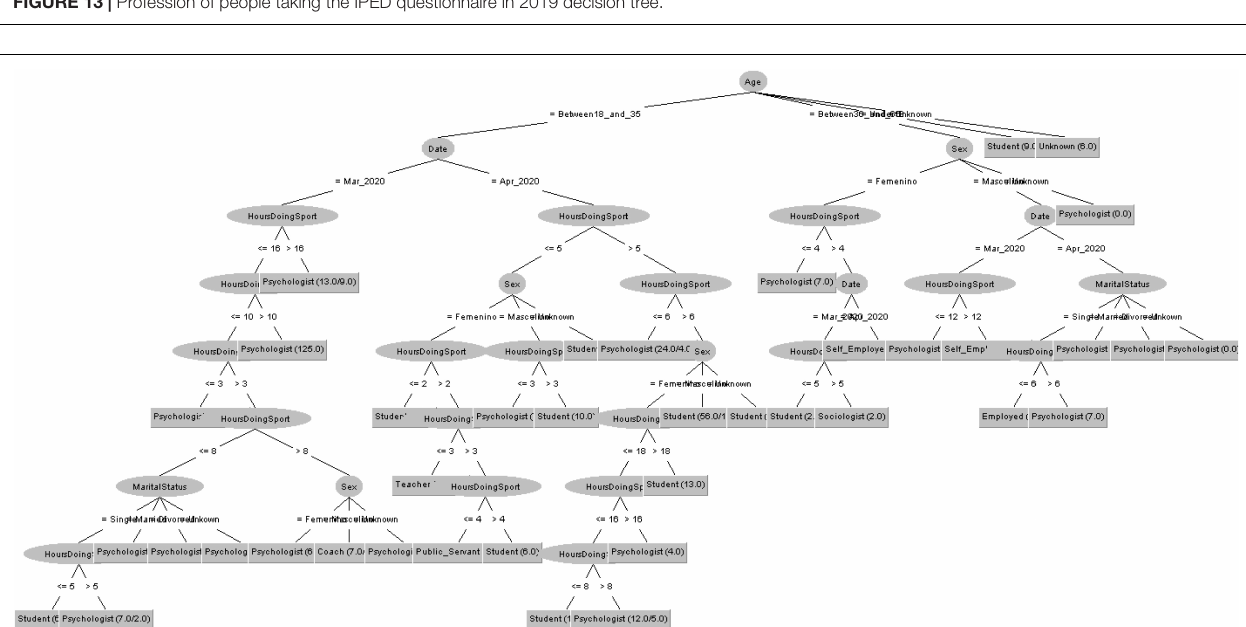
FIGURE 13 | Profession of people taking the IPED questionnaire in 2019 decision tree.